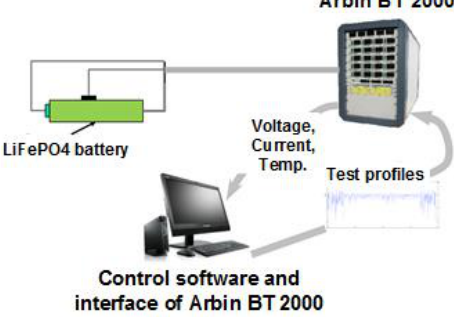
Figure 16. Experimental setup.